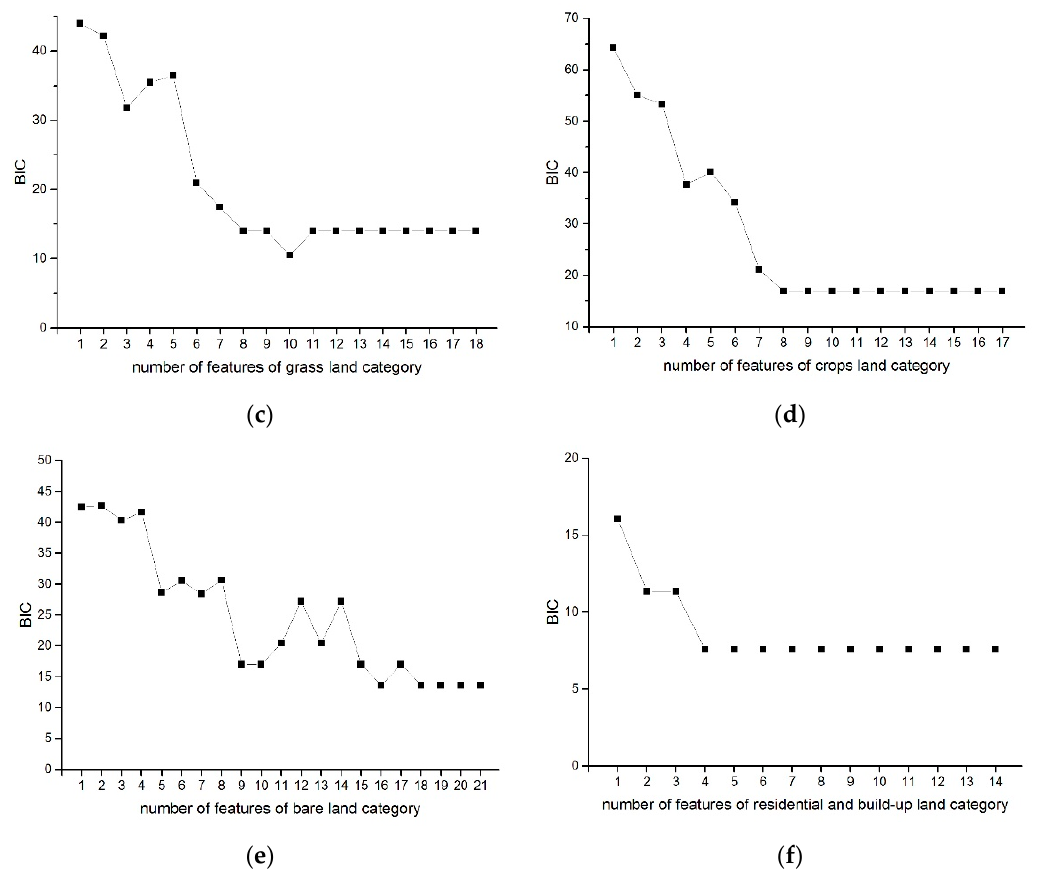
Figure 2. Graph of BIC against the number of features for the G-PLSGLR. Water—BIC vs. number of features ( a ); Forest land—BIC vs. number of features ( b ); Grass land—BIC vs. number of features ( c ); Crops land—BIC vs. number of features ( d ); Bare land—BIC vs. number of features ( e ); Residential and build-up land—BIC vs. number of features ( f ).